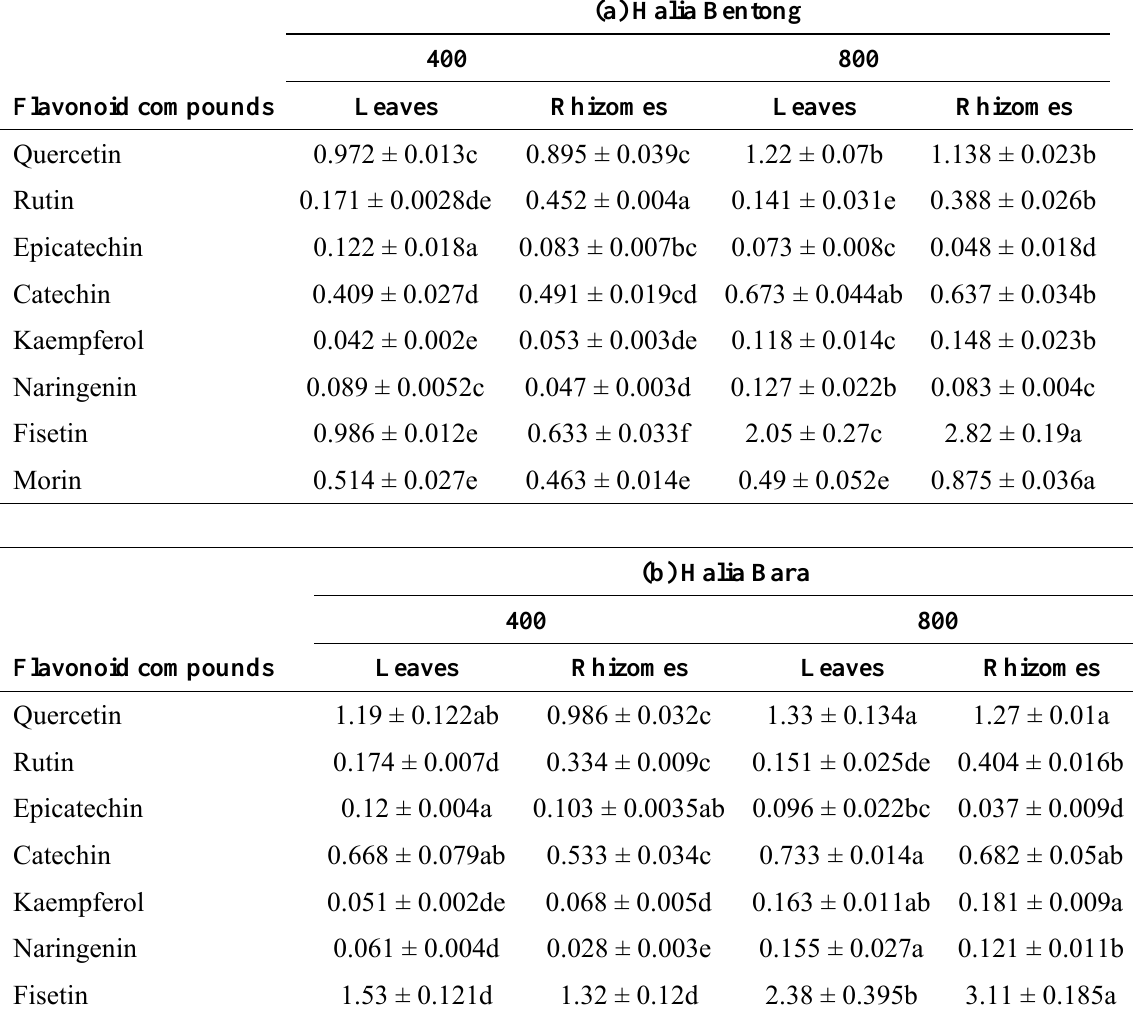
concentrations. 2